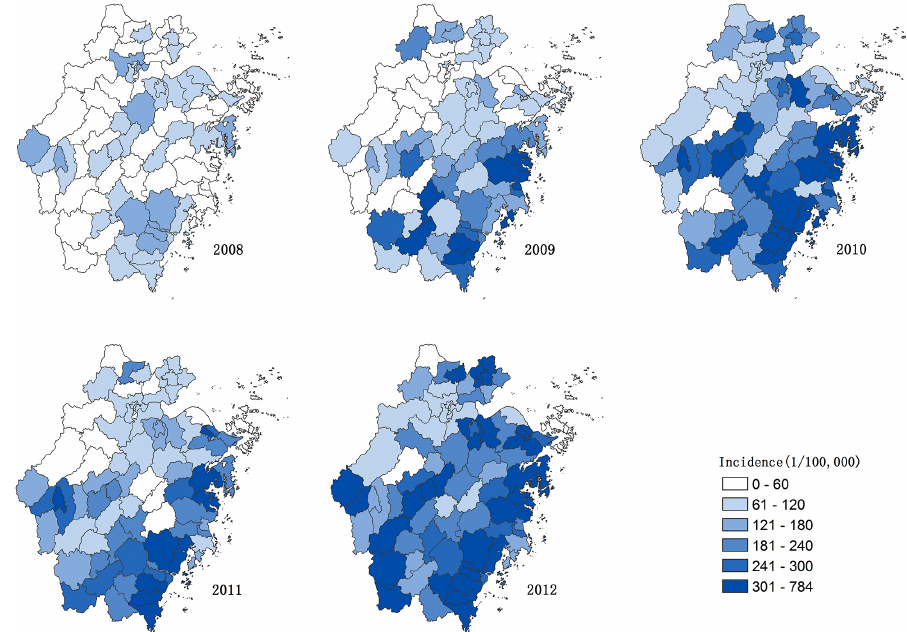
Fig 3. The incidence rates of counties in Zhejiang Province, 2008 –